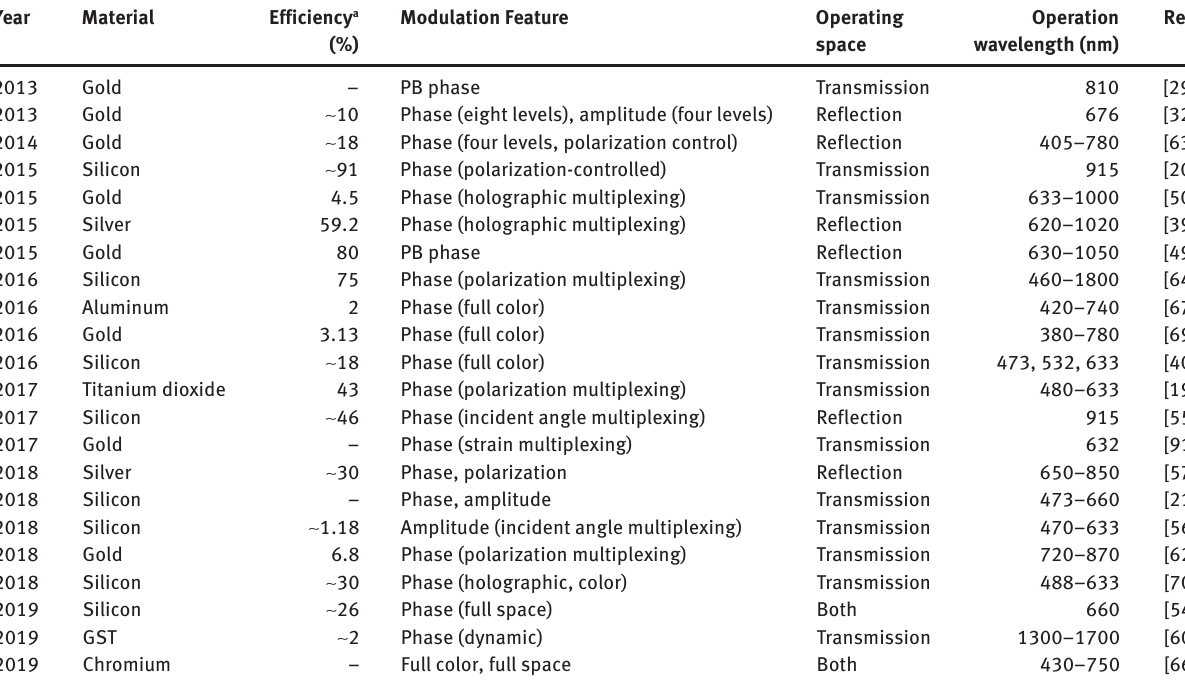
Table 1: Conclusive table on